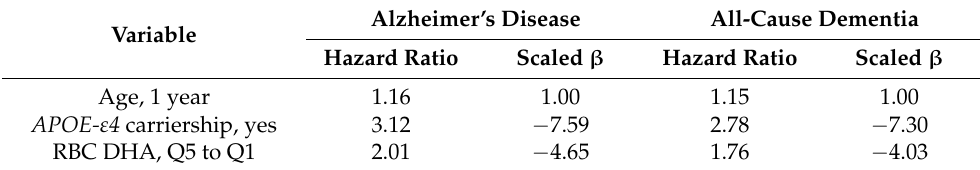
Table 6. Theoretical effects of selected variables on event-free years of life ( n =